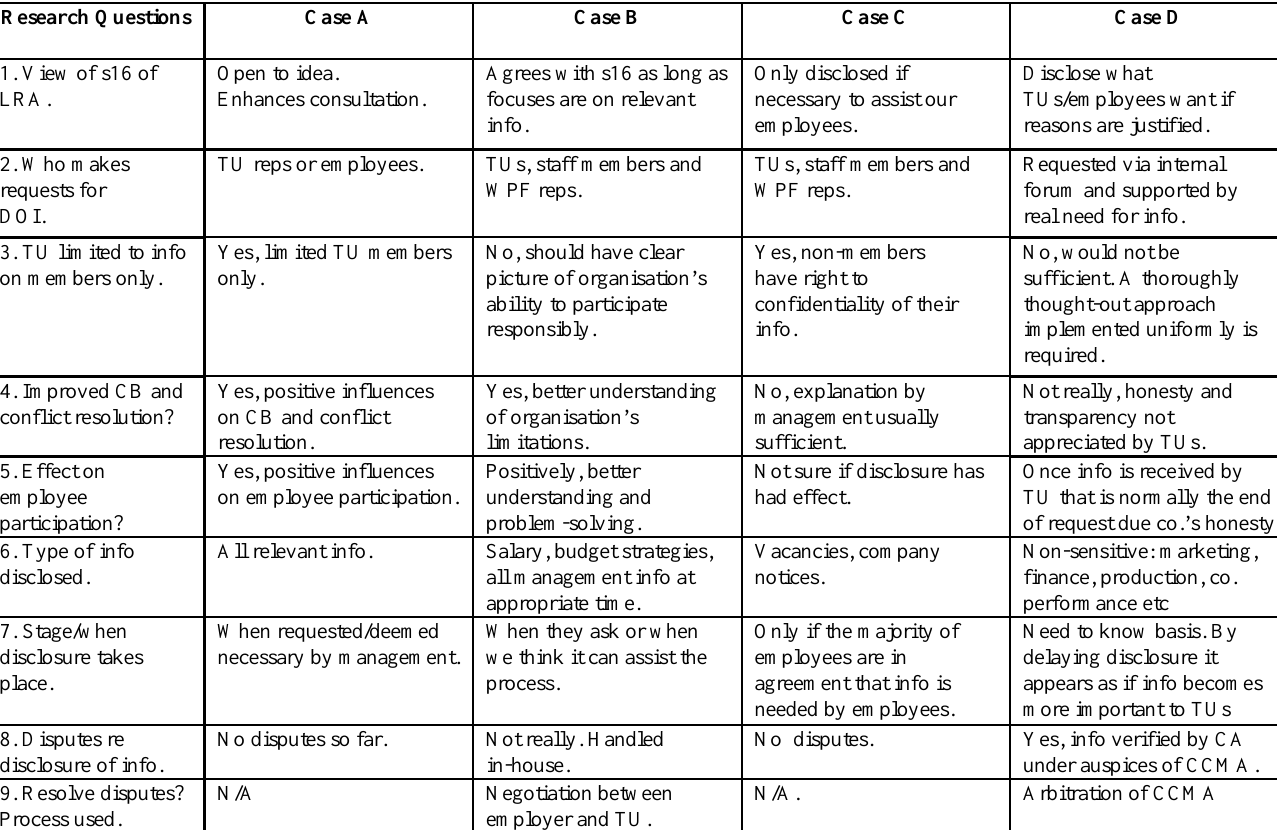
Table 1: Compilation of all management representatives’ responses on disclosure of information (DOI) (TU = Trade Union; CB = Collective Bargaining; ; WPF= Workplace Forum; LRA = Labour Relations Act) Research